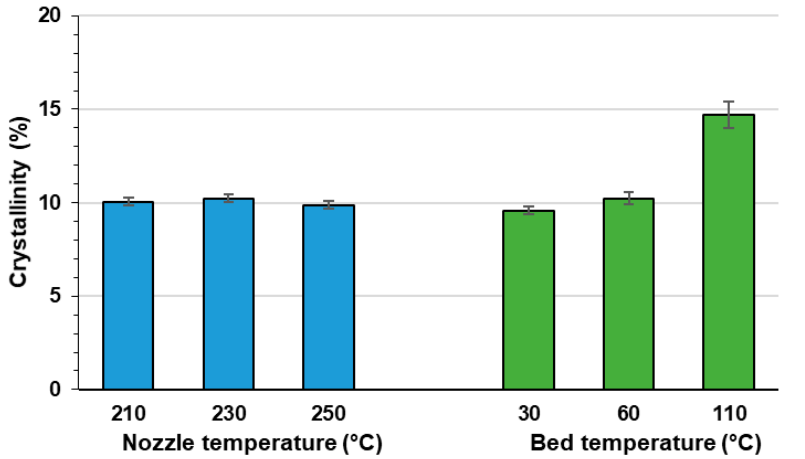
Figure 12. Influence of the bed and nozzle temperatures on the crystallization percentage of PLA/Hytrel-20%.